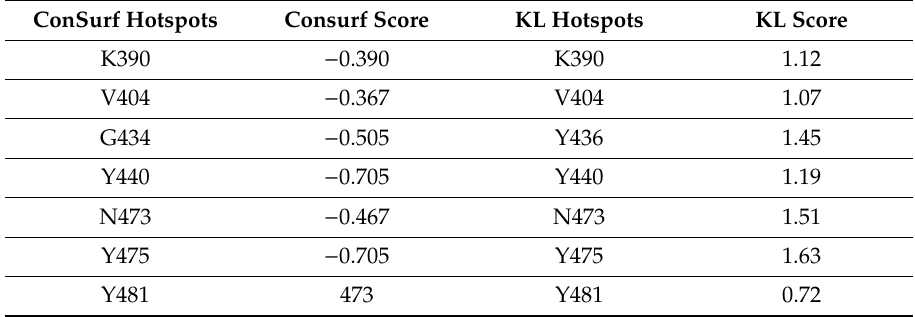
Table 1. The evolutionary conserved hotspot residues determined with ConSurf and KL scores. ConSurf Hotspots Consurf Score KL Hotspots KL Score K390 −